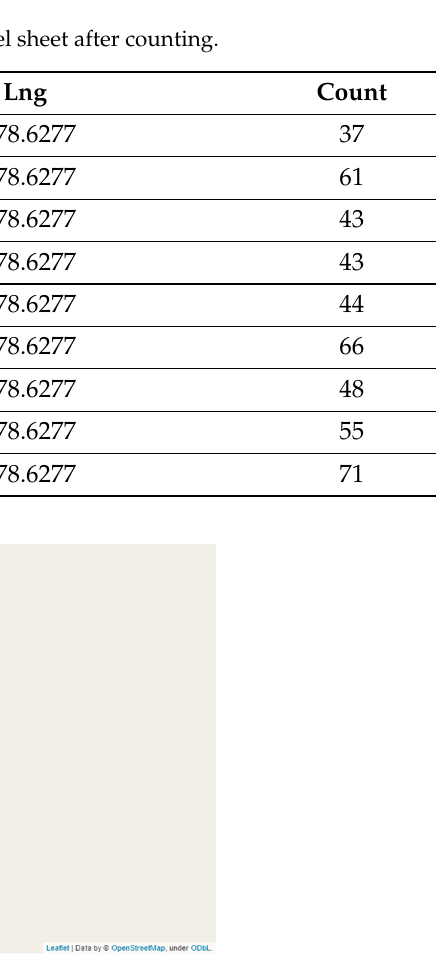
Figure 8. Mapping the GPS data after